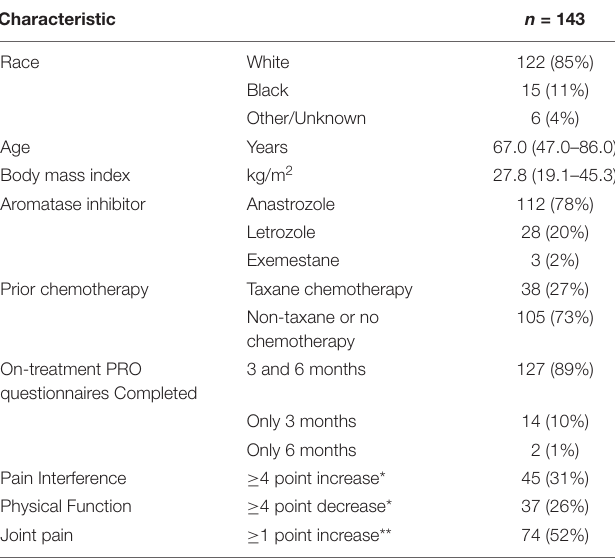
TABLE 1 | Clinical information of subjects included in the